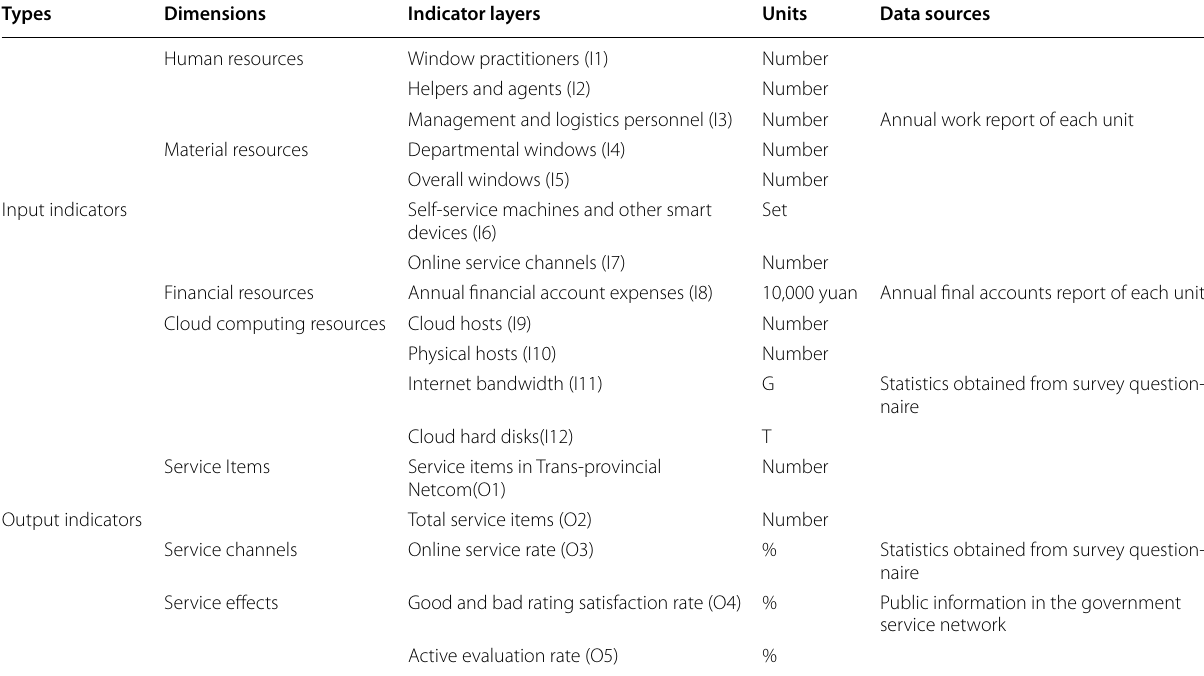
Table 1 Input and output index system of the government service resources